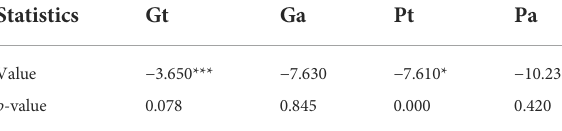
TABLE 4 Co-integration outcomes.